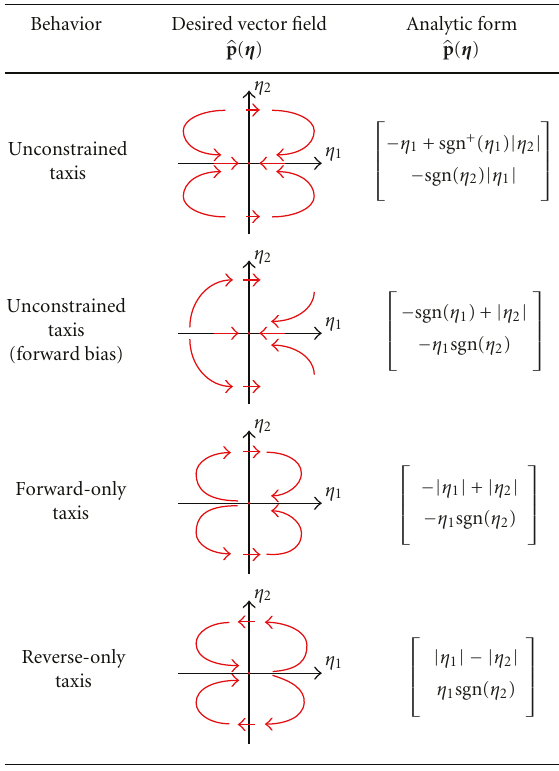
Table 1: Summary of reference vector fields, (cid:16) p ( η